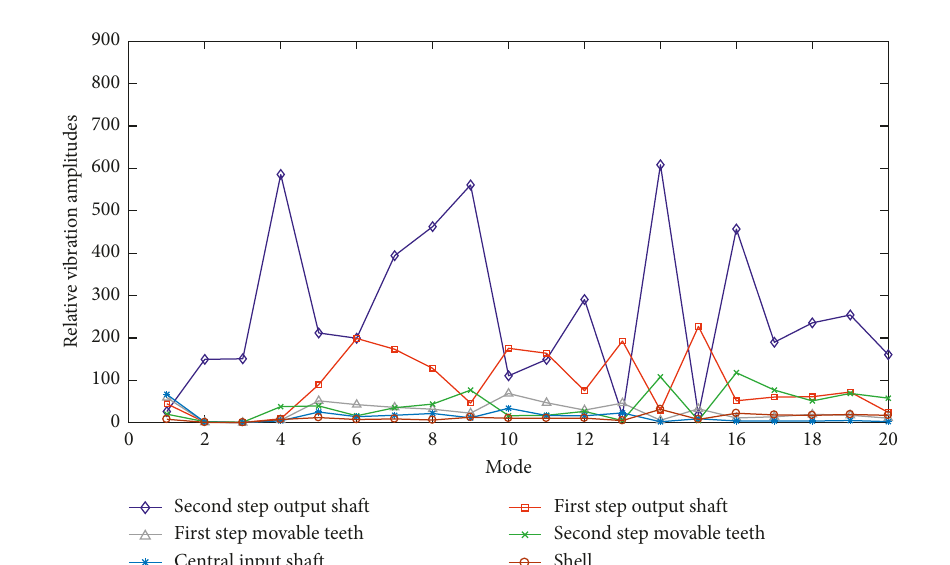
Figure 8: Relative vibration amplitudes of the main elements for the first 20 order